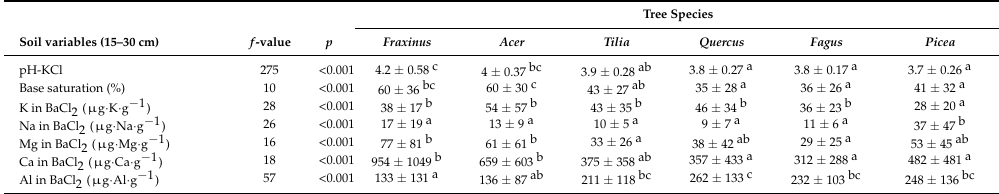
Table A3. Mean and standard deviation of the deeper soil (5–15 cm) properties for each tree species across all six common gardens. Significant differences according to the Tukey post-hoc test between tree species are indicated with letters, means with the same letter are not significantly different (Tukey post-hoc tests on LME models, 1|Site).